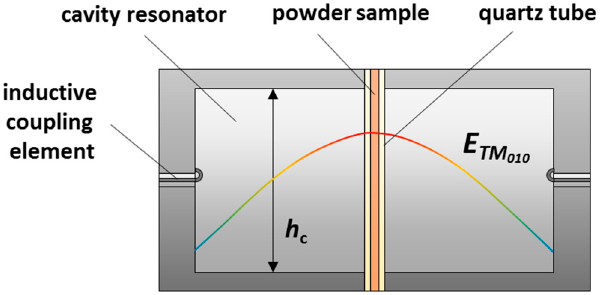
Figure 6. Setup for the characterization of the dielectric properties of ceria powder at room temperature.